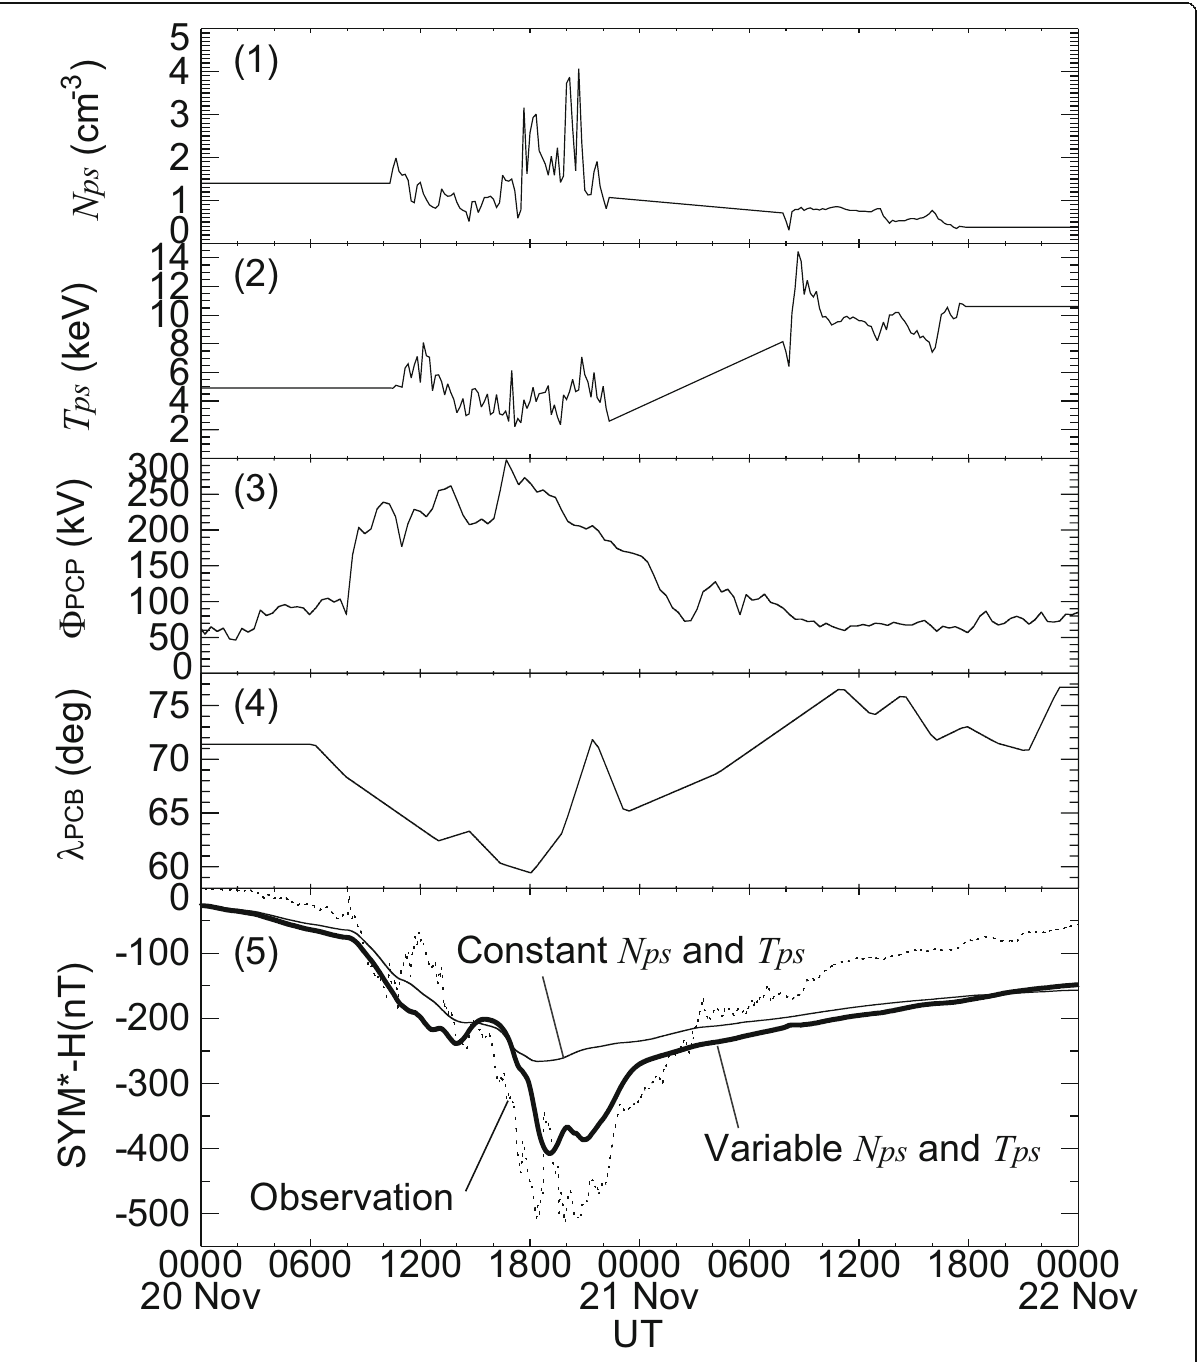
Fig. 1 Simulated storm-time Dst (SYM-H) index during the magnetic storm of 20 – 21 November 2003. The input parameters (plasma sheet density N ps , plasma sheet temperature T ps , strength of the convection electric field Φ PCP , magnetic latitude of the polar cap boundary at which Φ PCP is imposed) used to drive the simulation are summarized in the top 4 panels. (Ebihara et al.